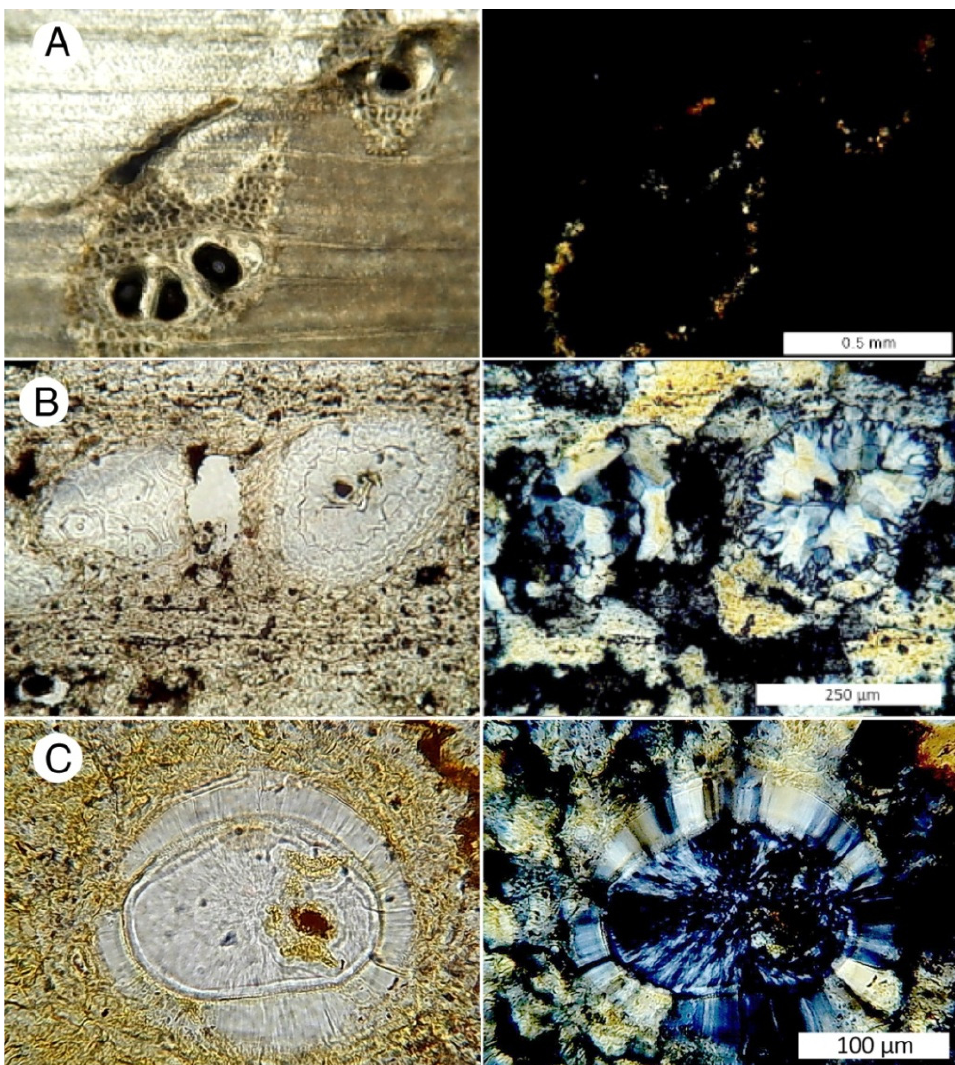
Figure 14. Petrographic thin sections showing mineral variations in Khorat specimens (transverse views). Each photo pair shows ordinary transmitted light illumination on the left, crossed polarized light at right. ( A ) Specimen S-2 is predominately composed of opal-A, which is black (isotropic) under polarized light. Opal-CT is visible as a narrow band. ( B ) Specimen S-10, showing a pair of vessels in wood mineralized with crystalline quartz. ( C ) Specimen S-11.Vessel wall and peripheral cells are mineralized with chalcedony. The surrounding tissue has been replaced by fine-grained quartz.